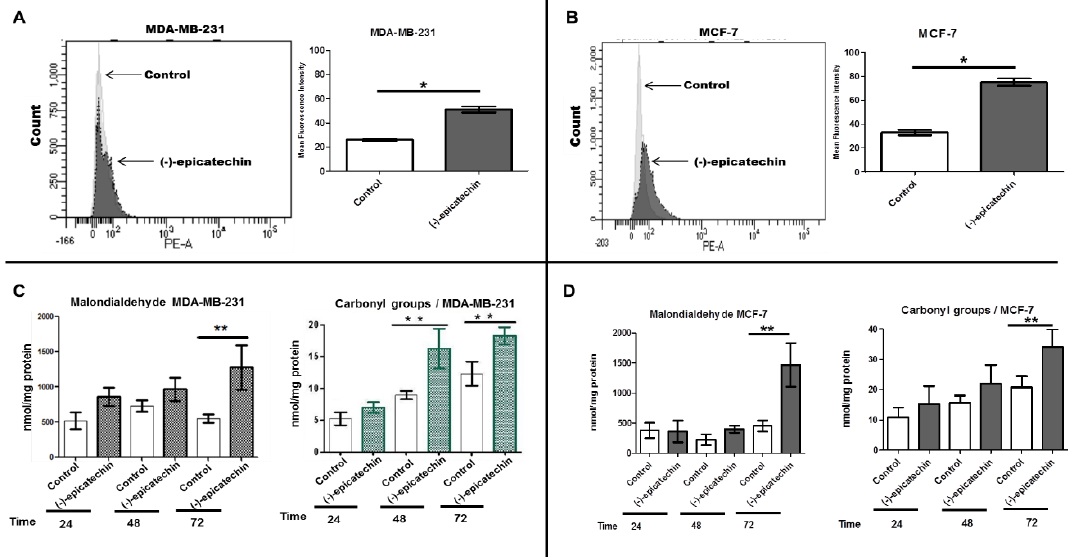
Figure 5. Effects of (−)-epicatechin on mitochondrial reactive oxygen species (ROS) production and oxidative damage. Panels A and B show the corresponding histograms and mean fluorescence intensity detected in the control cells (without) and the (−)-epicatechin-treated MDA-MB-231 and MCF-7 cells, respectively. The data represent the means ± SD (n = 3). * p < 0.05, compared to the control group. C and D show the values of malondialdehyde (MDA) and carbonyl groups that were generated by (−)-epicatechin on MDA-MB-231 and MCF-7 cells, respectively. The data are expressed as the means ± SD and analyzed by Student’s t -test (* p < 0.05).